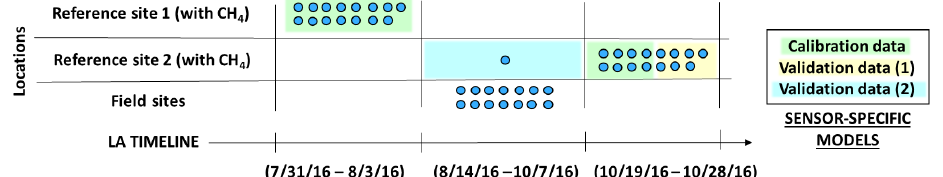
Figure 5. Timeline for LA indicating when Y-Pods were co-located together with reference instruments before and after the field deployment, as well as which data were used for calibration generation (training data) versus model validation (testing